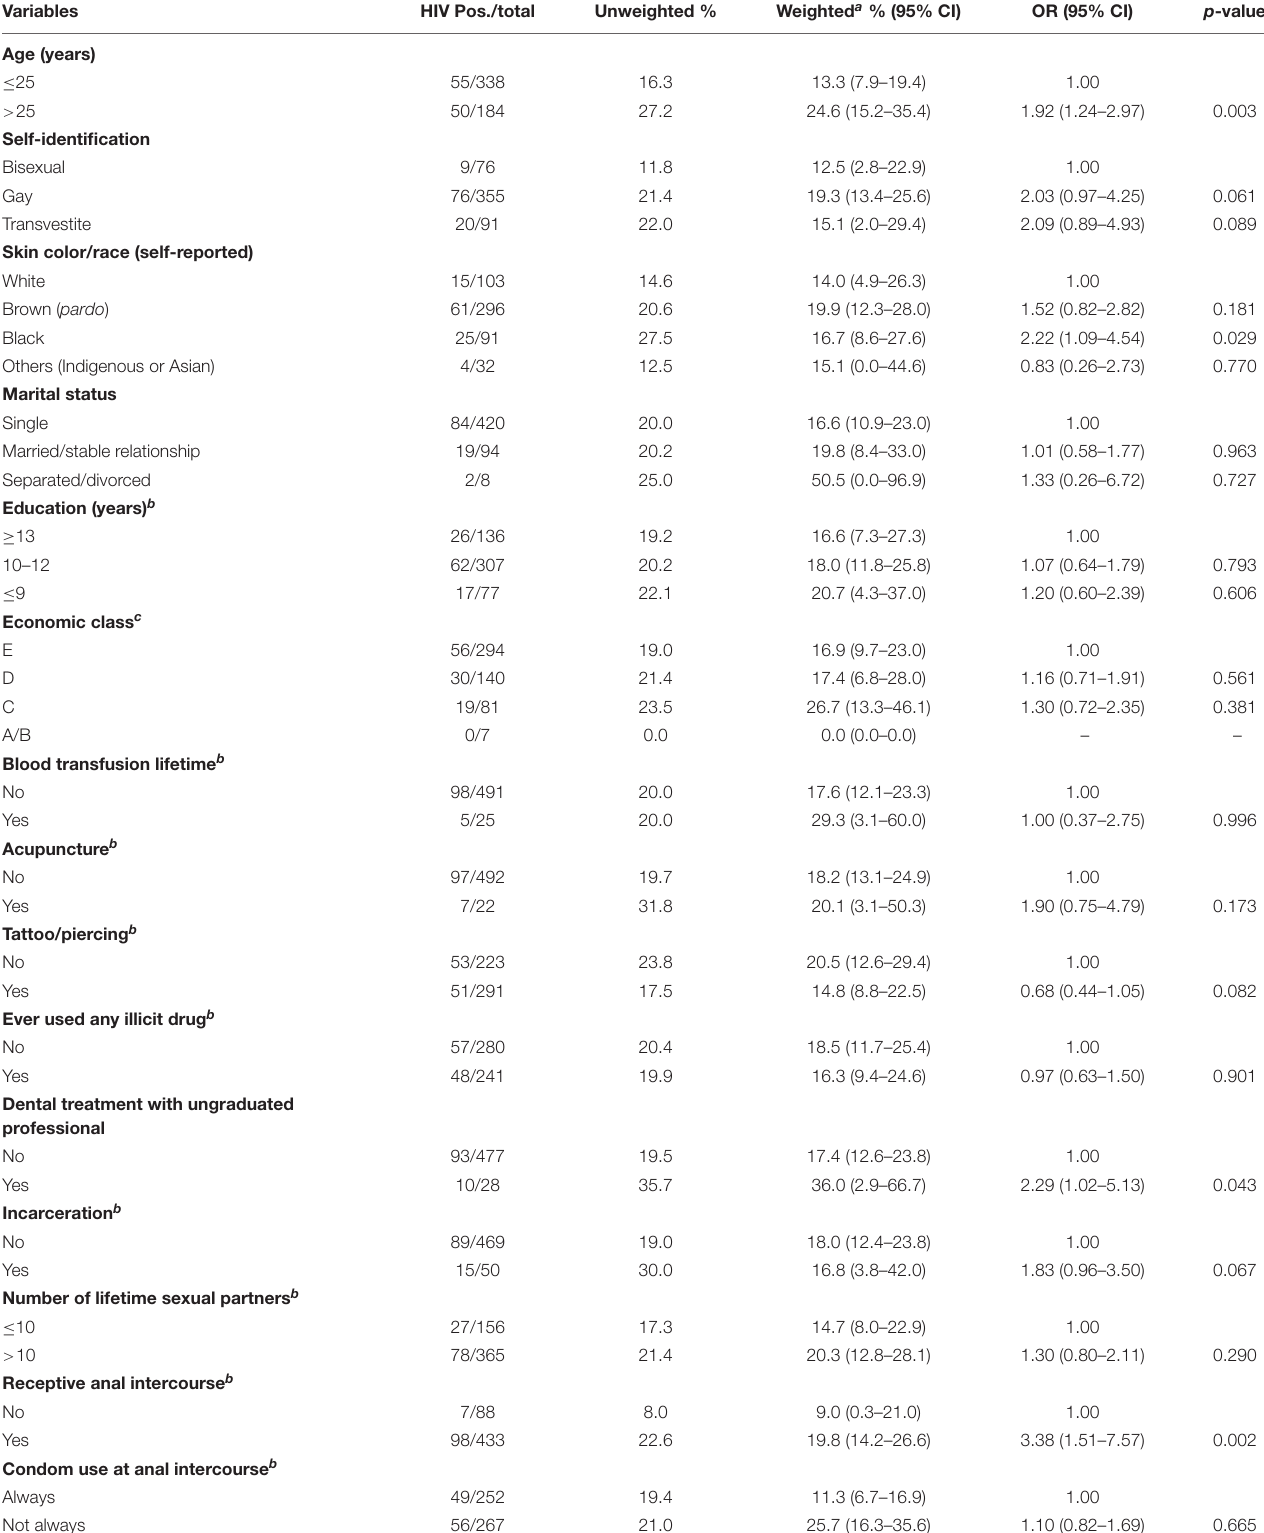
TABLE 2 | Demographic and behavioral characteristics associated with HIV infection among MSM from Goiânia, Central-Western Brazil.